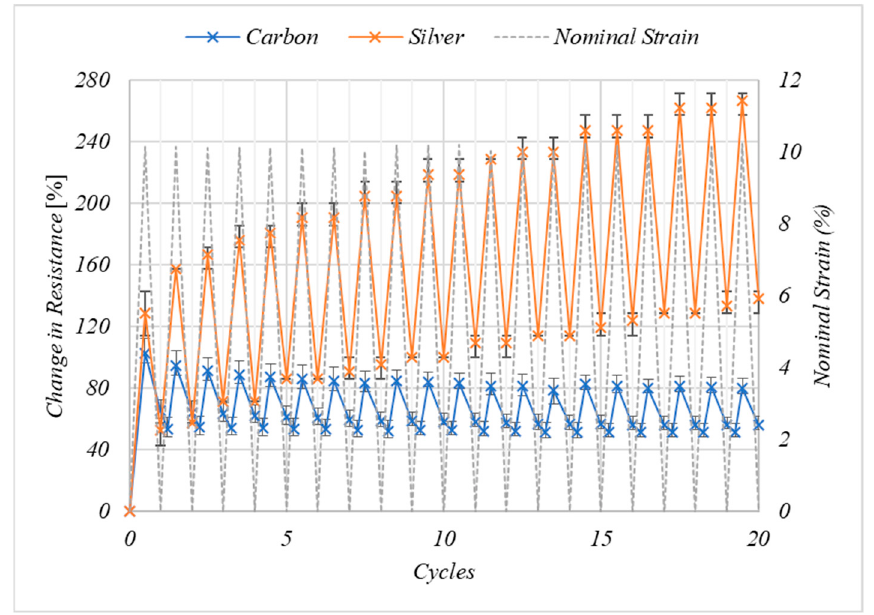
Figure 6. The effect of 20 cyclic strains to 10% nominal strain on the resistance of the coatings relative to their value at 0% nominal strain from n = 3 samples where error bars represent the range of values.